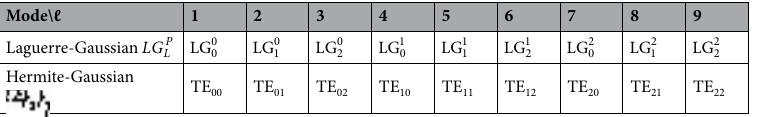
Table 1. Mapping between single index  and dual index characterizing Laguerre-Gaussian and Hermite- Gaussian